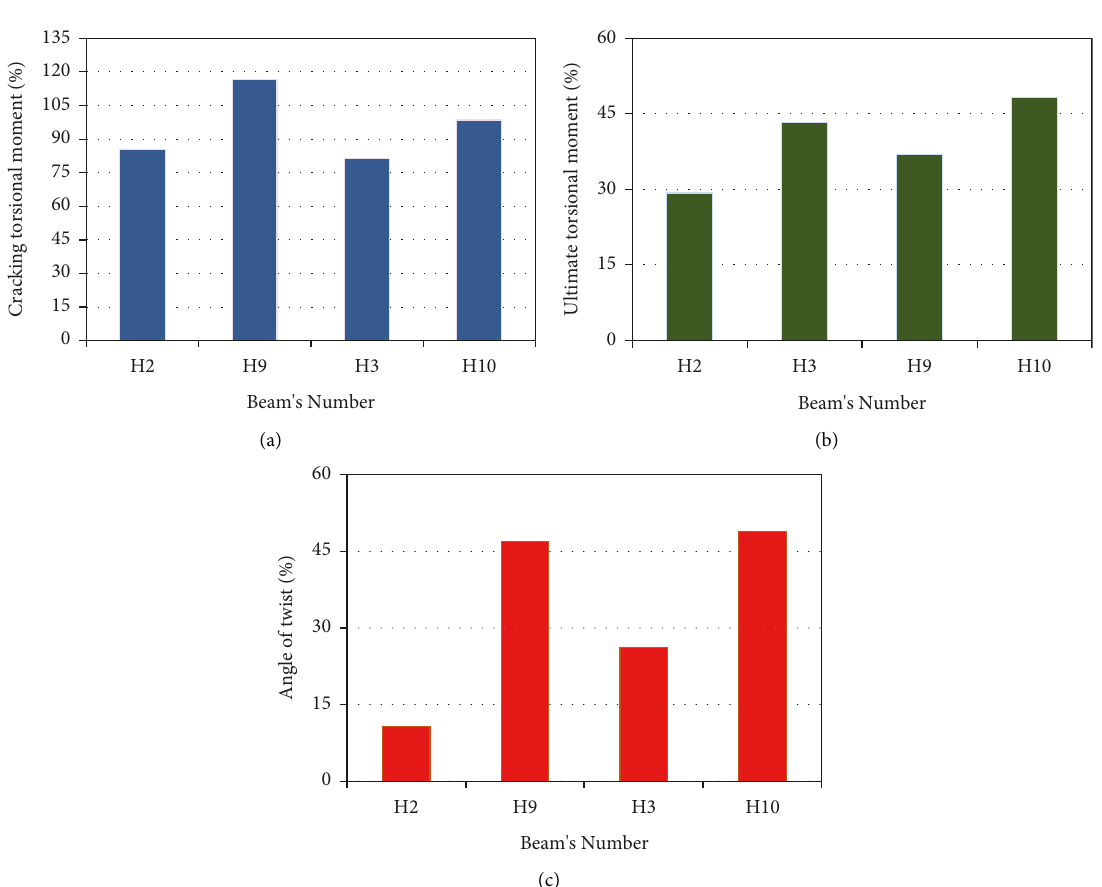
Figure 9: (a) Cracking torsional moment improvement. (b) Improvement of the ultimate torsional moment. (c) Twist angle